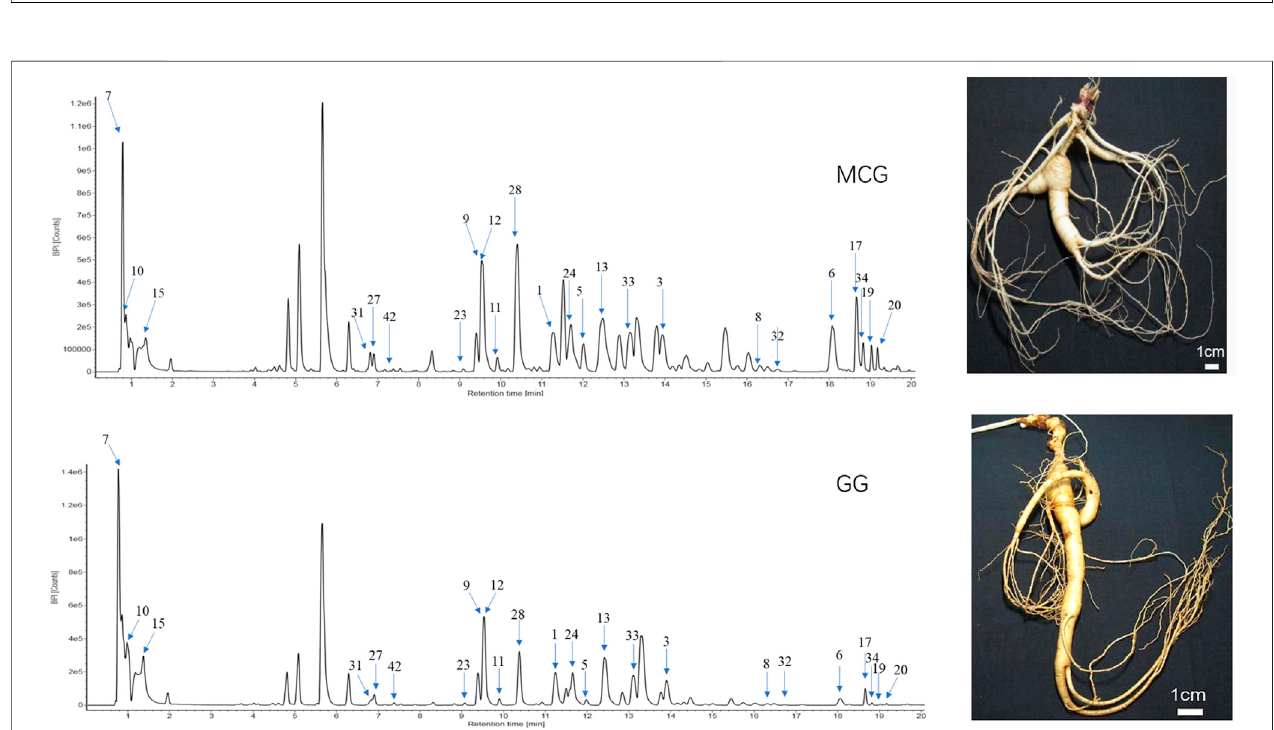
FIGURE 3 | UHPLC/IM-QTOF-HDMS E of MCG and GG in the negative ion modes. MCG: the root and rhizome of Mountain-Cultivated Panax ginseng C. A. Mey; GG: the root and rhizome of Garden Panax ginseng C. A. Mey. (CG).